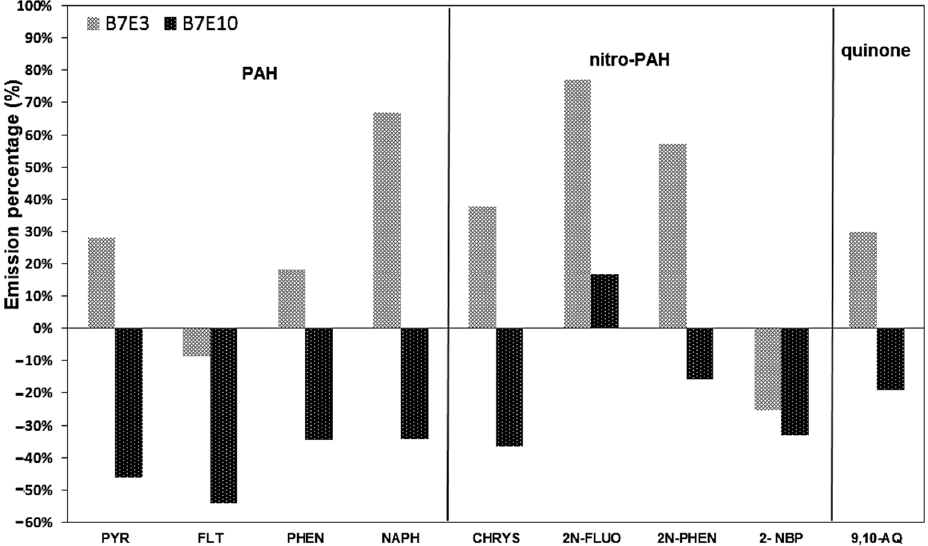
Figure 6. Percentage variation of individual emission of PAH, nitro-PAH, and quinones when comparing B7E3 and B7E10 with B7 for PM 2.5 .